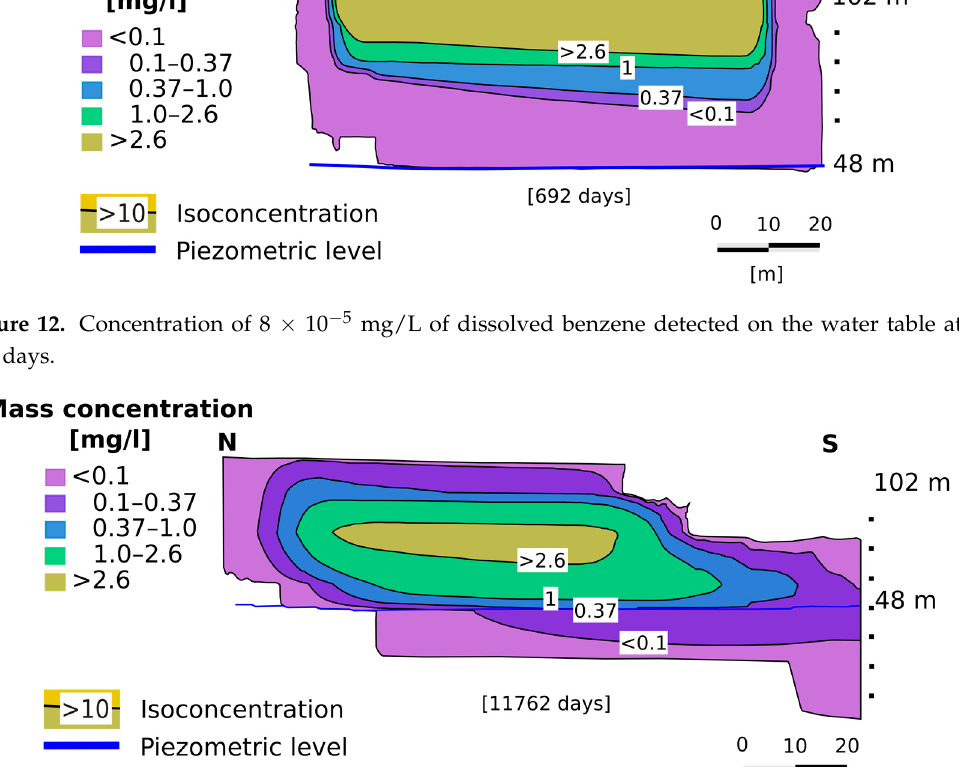
Figure 13. Maximum concentration of 0.37 mg/L of dissolved benzene detected on the water table at 11762 days (32 years and two months).